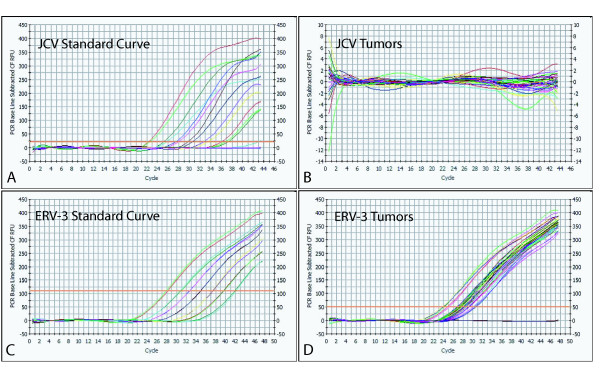
JC virus sequences are not detected in embryonal brain tumors. JC virus plasmid DNA is detectable over a wide range of dilutions when added to genomic DNA (A), but was not identified in DNA extracted from a range of embryonal brain tumors (B). In contrast, the ERV-3 endogenous retrovirus is easily detected both using standard dilution curves (C) and in tumor DNA (D).